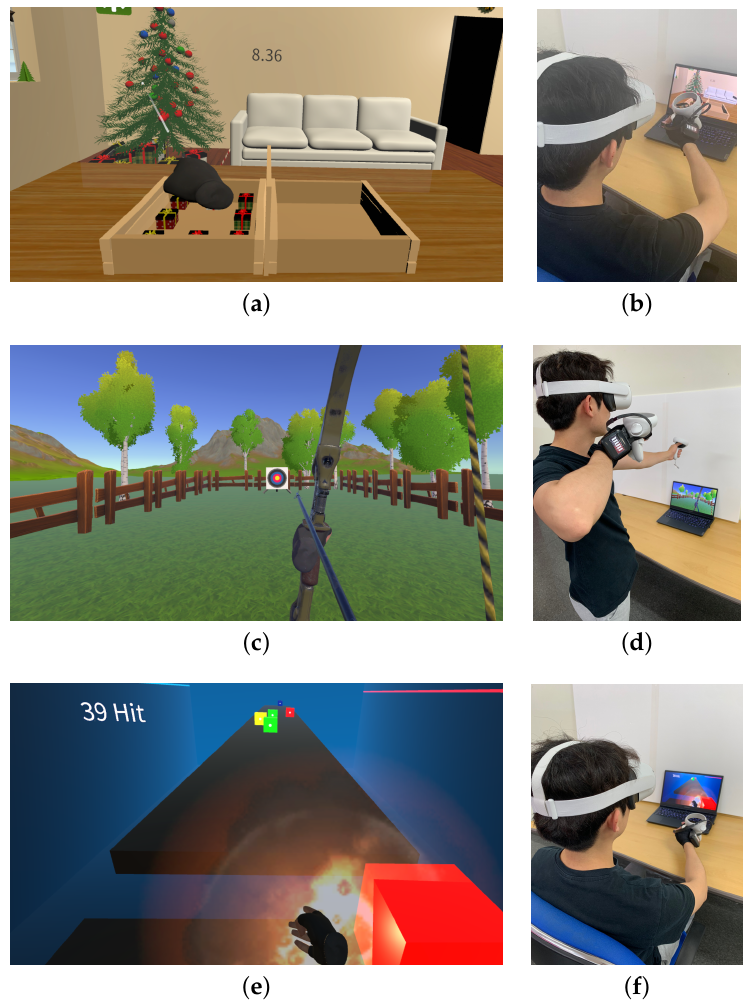
Figure 8. Training contents in virtual reality of a head-mounted display. ( a ) Moving block game for training static endurance; ( b ) the action of moving block game; ( c ) arrow shooting game for training dynamic endurance; ( d ) the action of arrow shooting game; ( e ) rhythm game for training accuracy; ( f ) the action of rhythm